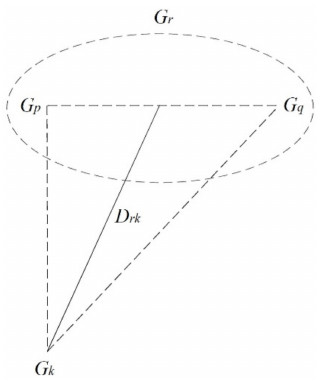
Figure 3. Conceptual diagram of the median linkage.